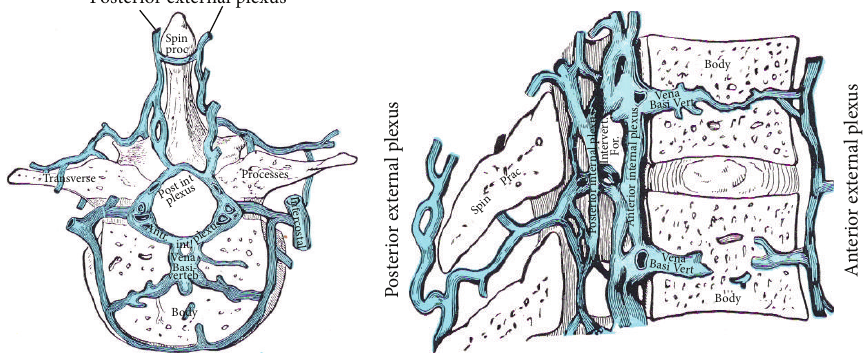
Figure 4: Vertebral venous